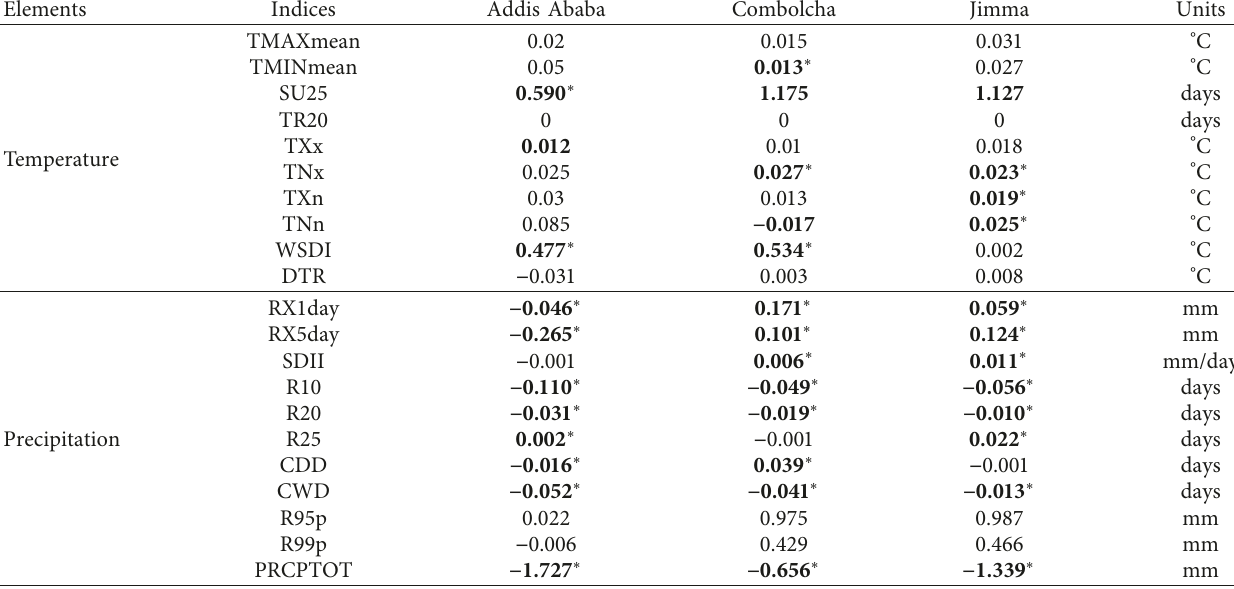
Table 3: Observed temperature and precipitation extremes for selected